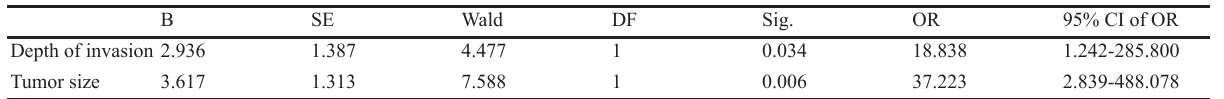
Table 4. Multivariable